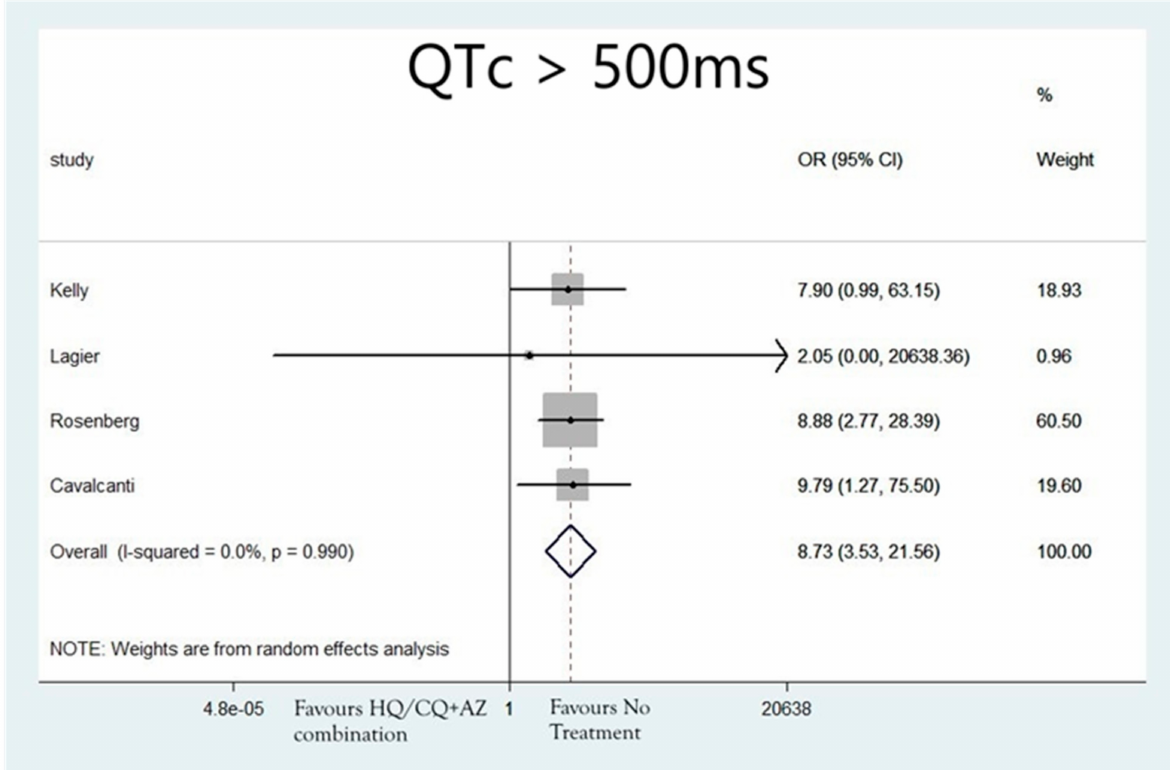
Figure 5. Risk of developing QTc > 500 ms in patients that received combination therapy with hydroxychloroquine and